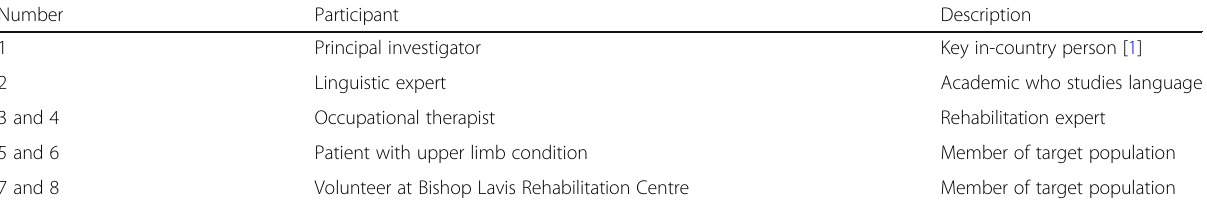
Table 1 Participants in harmonisation